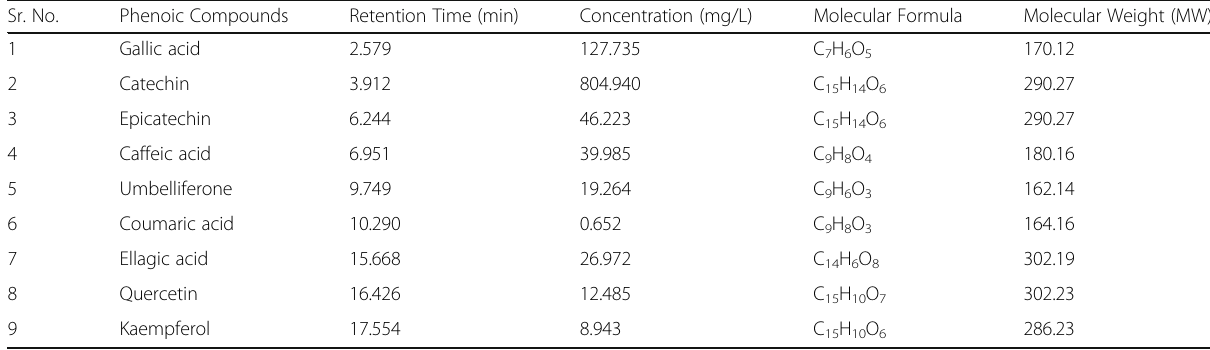
Table 7 Phenolic compounds identified in TES17 extract Sr. No. Phenoic